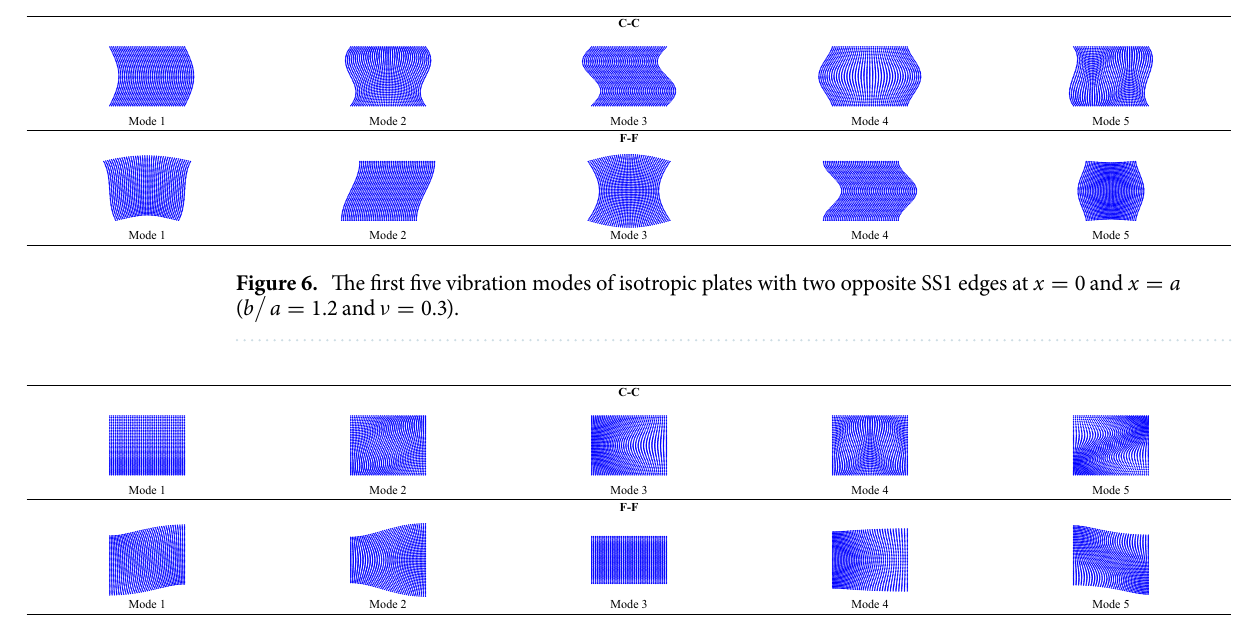
Figure 7. The first five vibration modes of isotropic plates with two opposite SS2 edges at x = 0 and x =